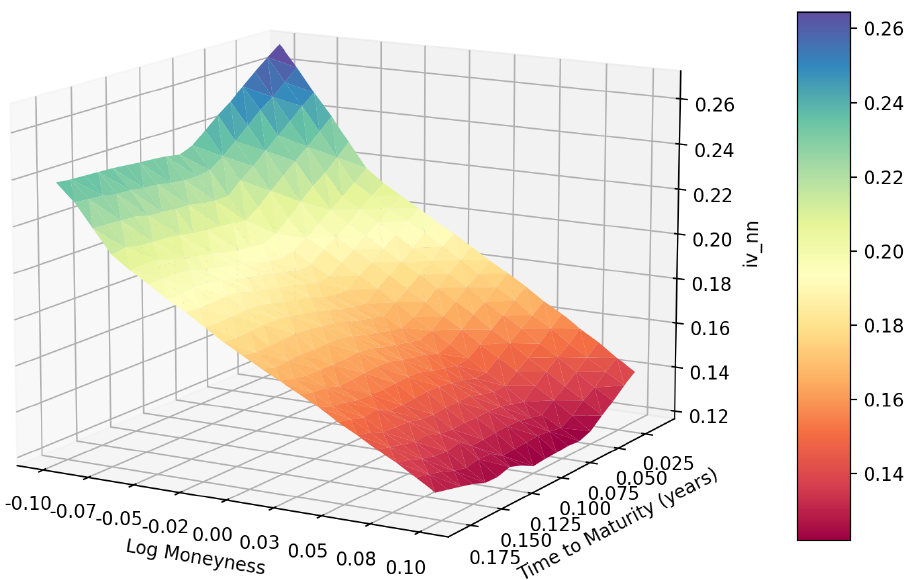
Figure 4. The Heston model’s IV surface inverted from S&P options data.